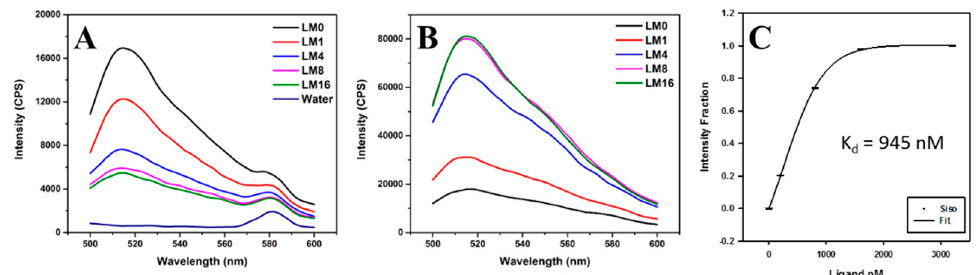
Figure 3. Fluorescence titration using sisomicin as titrant against annealed FM1 CUG×10 RNA repeats at 25 °C: ( A ) Fluorescence spectra of control experiments with DI water only and 5 nM of 6-FAM water solution titrated by sisomicin at siso-to-FAM molar ratios of 0, 1, 4, 8, and 16; ( B ) fluorescence spectra with ligand to RNA molar ratios—L/M at 0, 1, 4, 8, and 16; ( C ) K d value obtained from sigmoidal fitting; annealed FM1 CUG×10 RNA sample concentration 200 nM and volume size 150 µL; ligand addition volume size 1.5 µL; fluorescence setting: excitation at 485 nm, emission at 500–600 nm, and slit width of 3 nm.